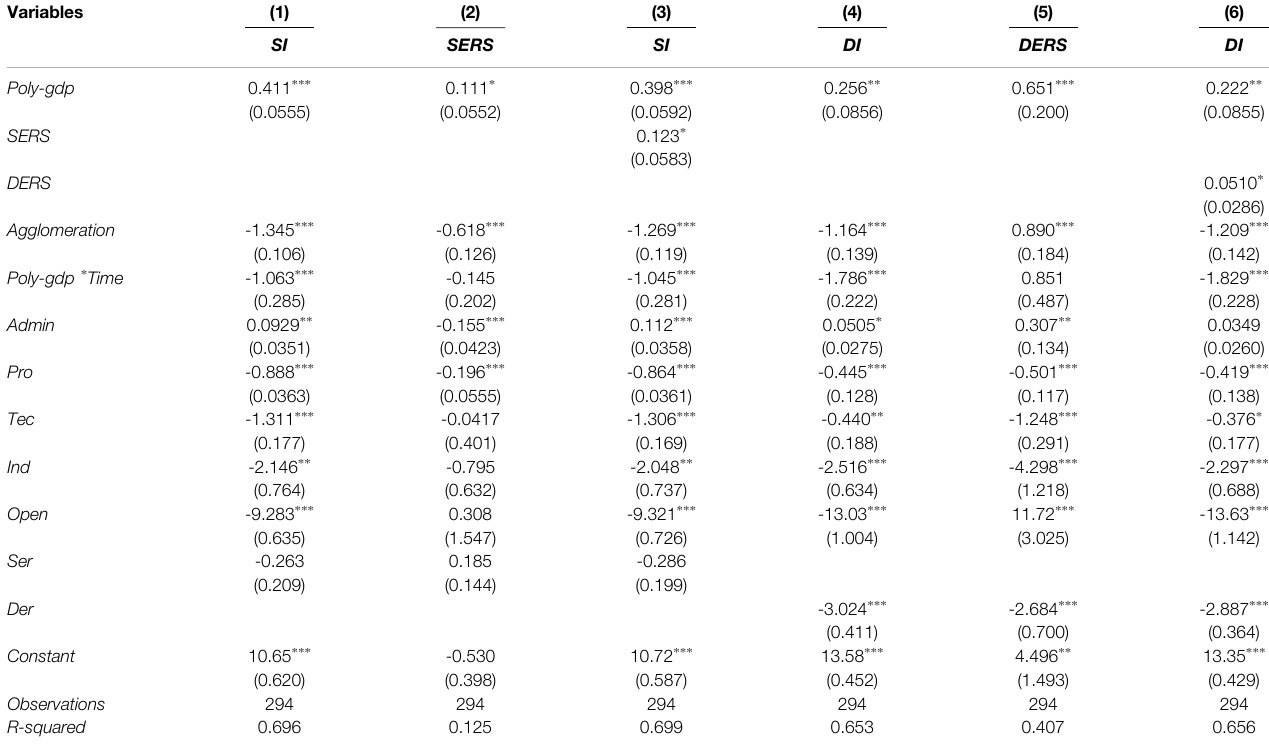
TABLE 7 | The mediating emission reduction effect of ERS .